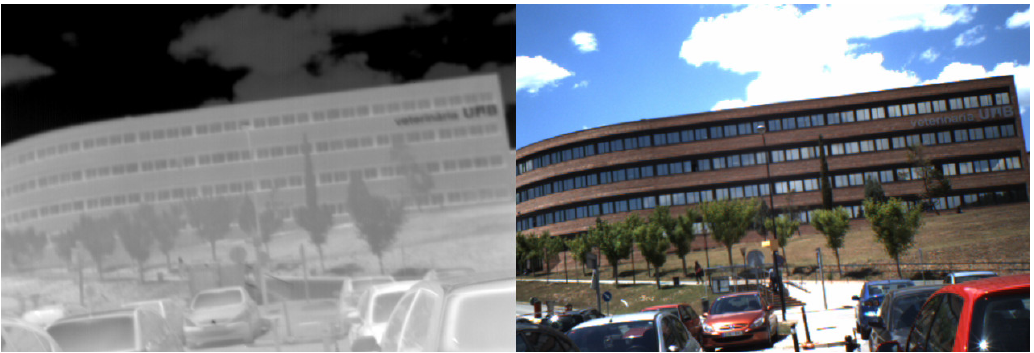
Figure 18. A Visible-NIR pair from the “Barcelona dataset”.